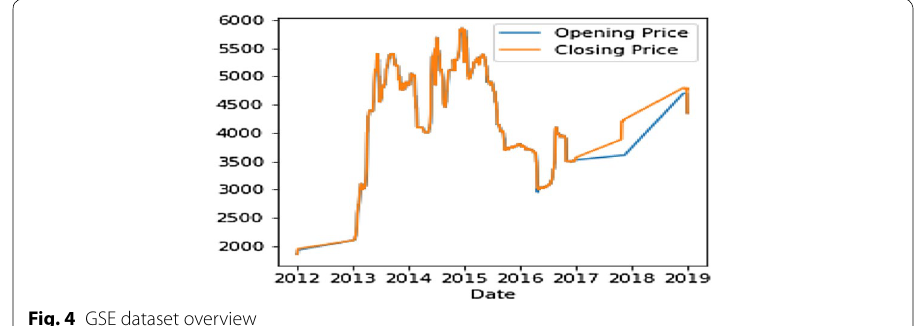
Fig. 4 GSE dataset